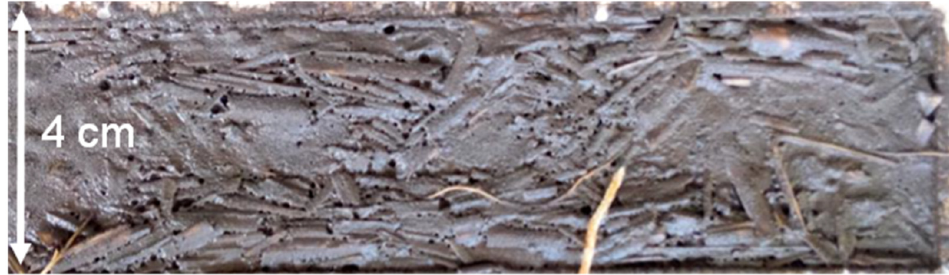
Figure 11. Fibers accumulation at the brick surface with a sieve shaker machine.